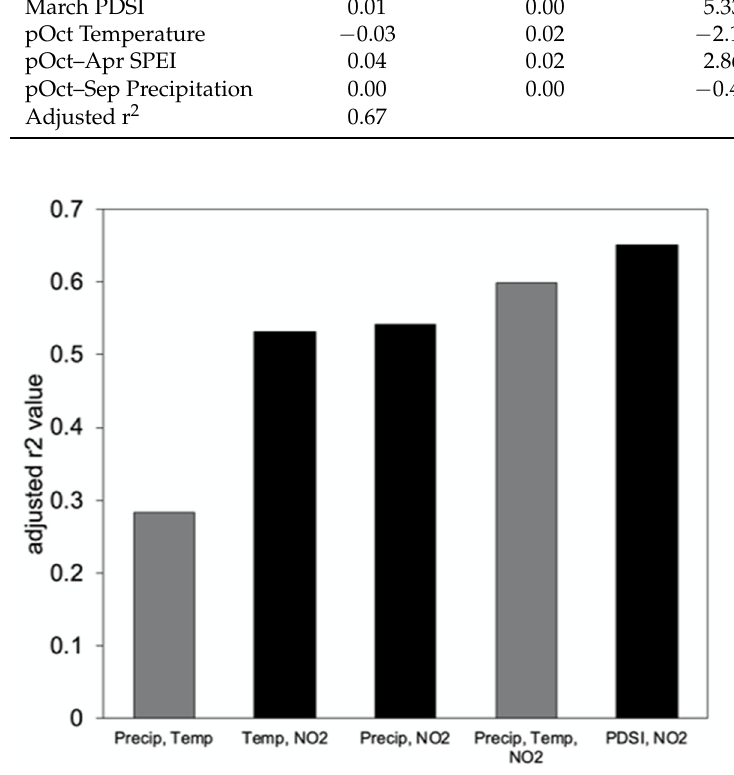
Figure 5. Adjusted r 2 values produced by different stepwise regression models. Variables included in the models were precipitation (pOct–Sep), temperature (pOct), NO 2 (pOct–Sep), and PDSI (March). The gray bars indicate all variables in the stepwise regression were significant at the 95% level (p < 0.05), the black bar indicates all variables were significant at the 99% level (p < 0.01).